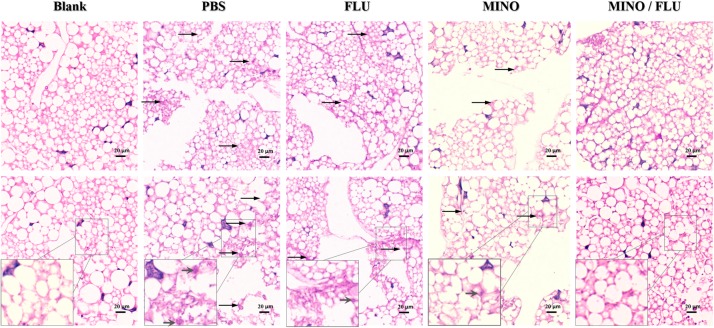
Histopathology of CN526-infected G. mellonella larvae treated with different drugs. CN526 (5 × 106 cells/larva) was used to infect the G. mellonella larvae (20 larvae for each group). Three hours after infection, the larvae were treated with 5.2 mg/kg FLU (FLU group), 6.3 mg/kg MINO (MINO group), or a combination of 5.2 mg/kg FLU and 6.3 mg/kg MINO (MINO/FLU group); the PBS group was used as a control. Treatment was given only once. Another group (Blank group) that was injected with 10 μl of sterile PBS was used as a negative control; this group was not treated with CN526 or drugs. Three larvae from each group were randomly chosen after 3 days of incubation and cut into 5-μm sections. The sections were stained with PAS reagent and observed under a microscope. Arrows indicate C. neoformans cells were observed surrounded by hemocytes in inflammatory nodules and tissue destruction. Magnification, 400×.